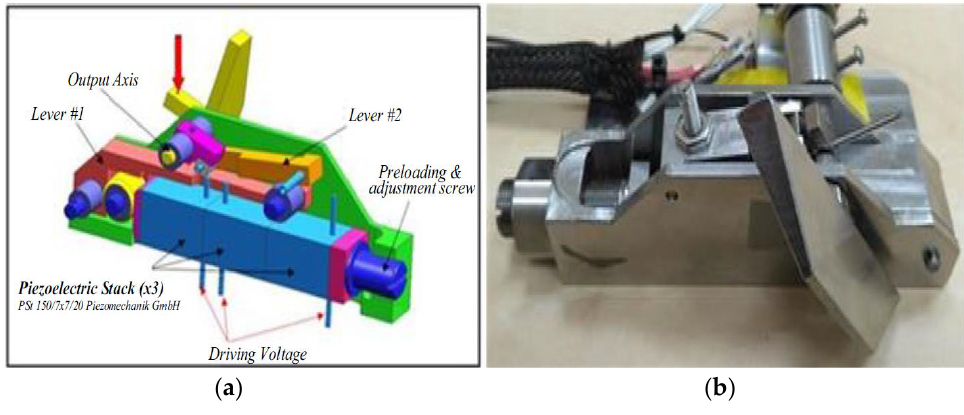
Figure 1. Three-stage lever scheme ( a ) and picture ( b ) [21]. These levers convert linear movements of 50 μm to angular movement s of 40